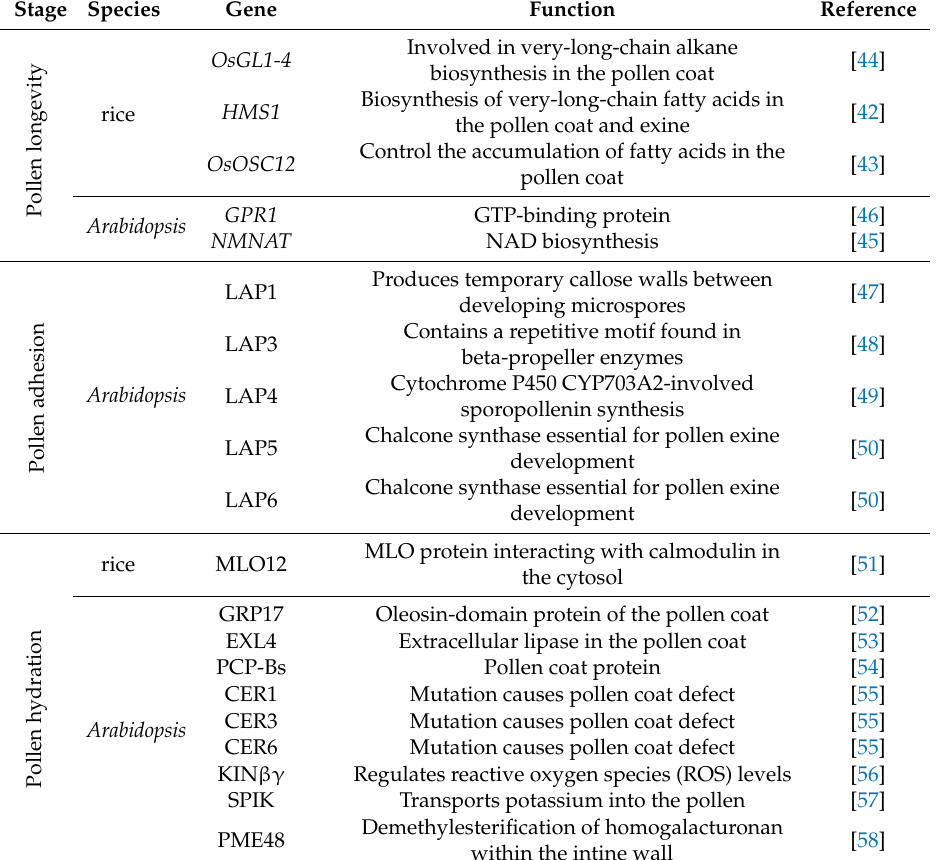
Table 1. Summary of the functionally characterized pollen associated-genes mentioned in this